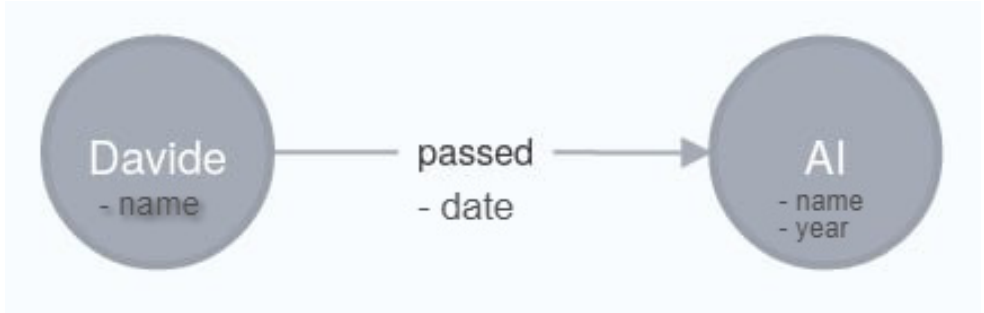
Figure 1. LPG representation of two nodes and a relationship with